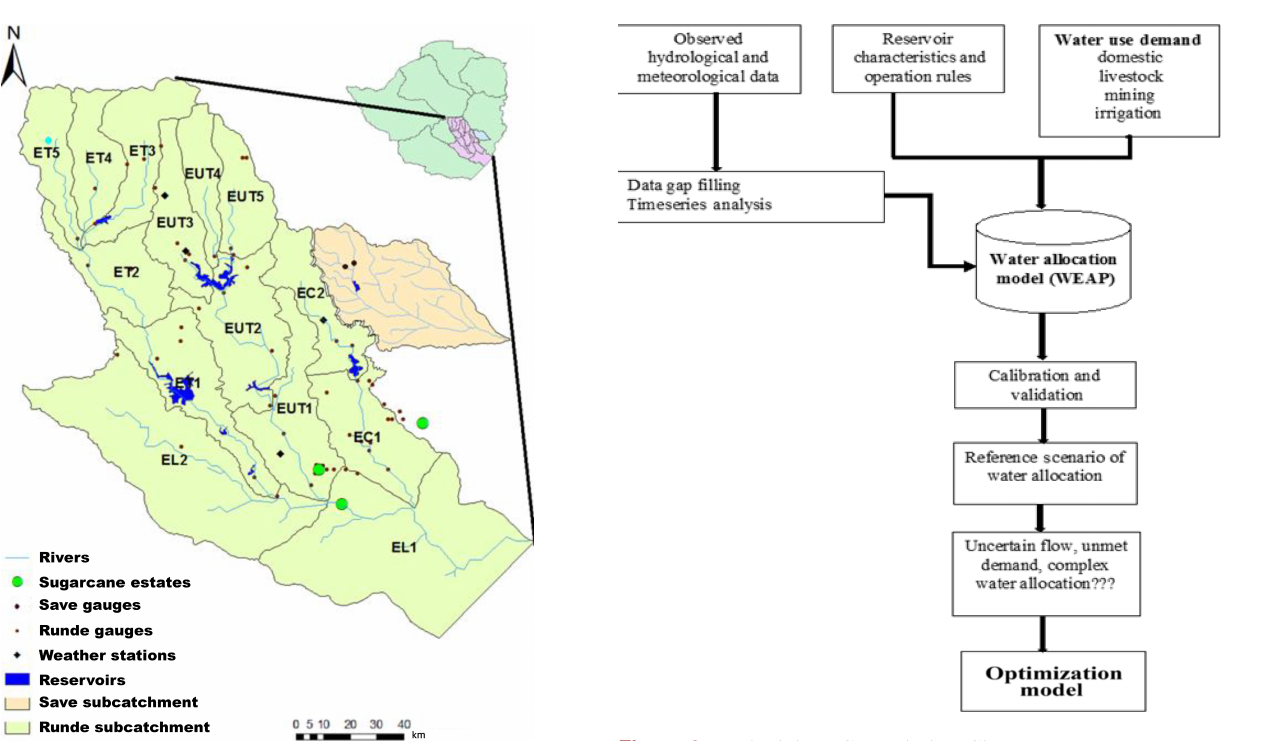
Figure 1. Study area map showing sugarcane estates and the water supplying reservoirs.